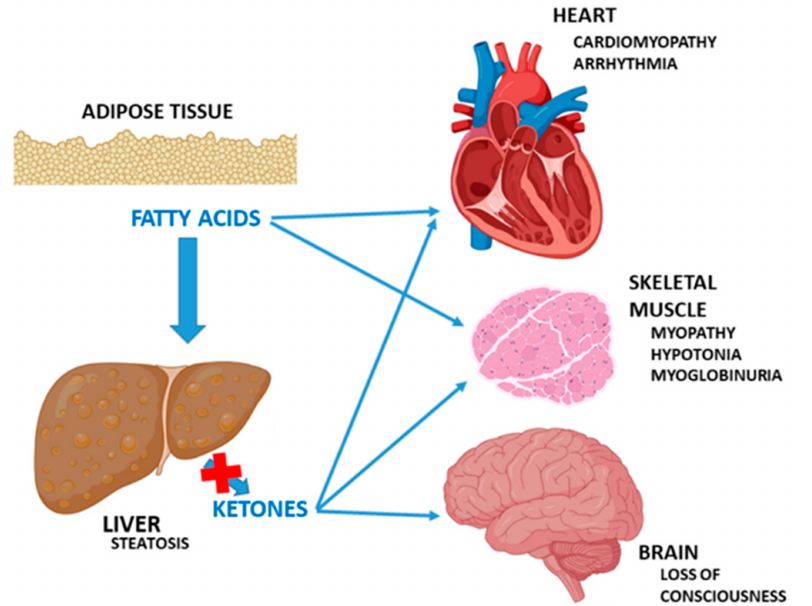
Figure 2. Defective fatty acid oxidation during fasting and metabolic stress. Adapted from Longo et al. [16] by